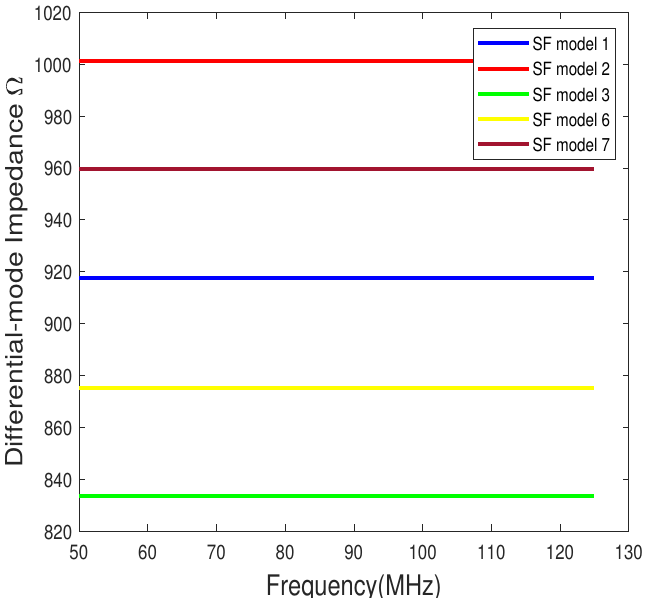
Figure 15. Differential mode characteristic impedance of single-fold (SF) antenna models with respect to frequency. SF models 4 and 5 will show similar characteristic impedance as SF model